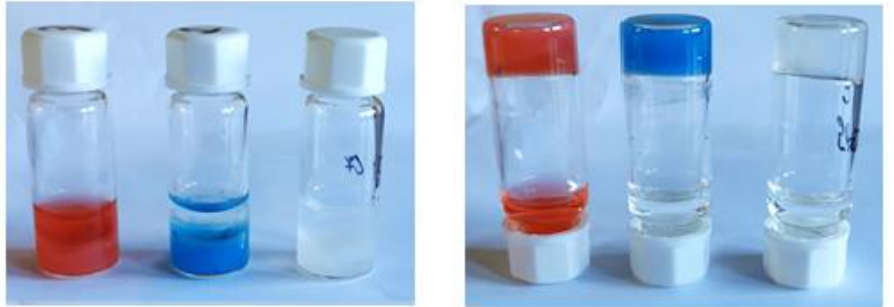
Figure 11. Representative images of hydrogels obtained from dehydrodipeptide 1 loaded with MO (left), MB (centre), and ciprofloxacin (right) layered with SBF solution (1.5 mL) following a saturating release study. After 168 h, 37% of MO and 23% of ciprofloxacin were released from the hydrogel.